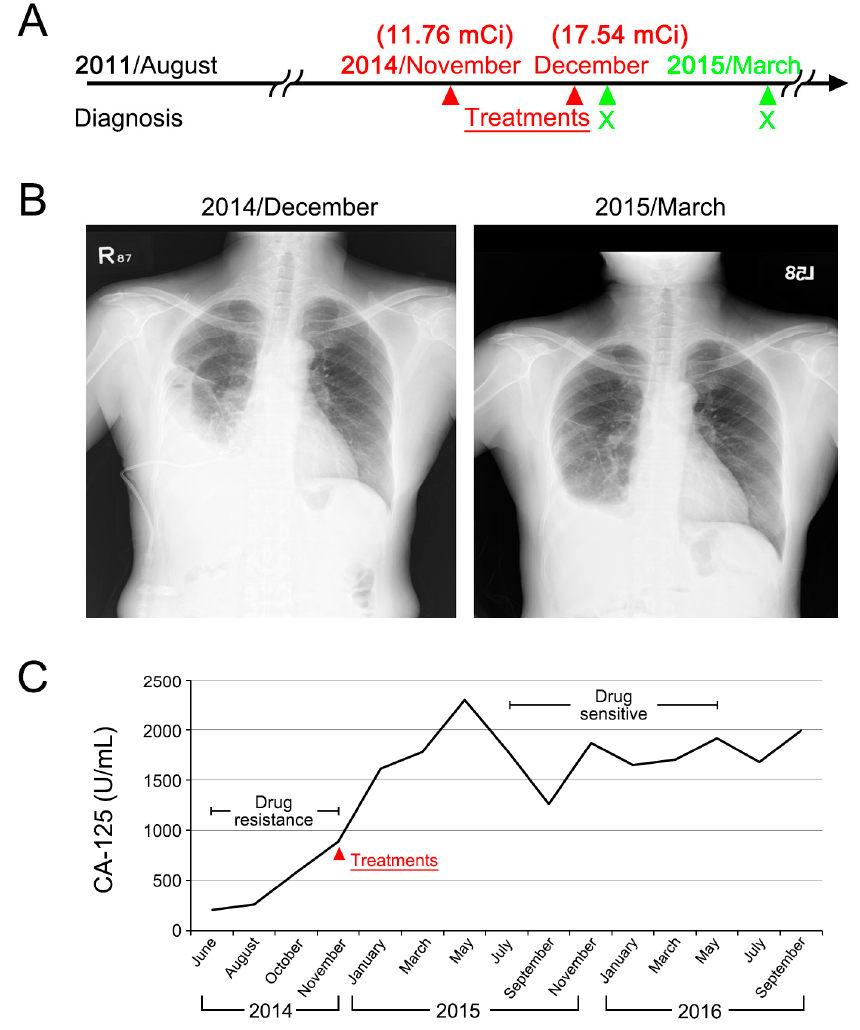
Figure 6. Case 1 presentation of a 188 Re-liposome phase I trial. ( A ) Clinical treatment scheme; ( B ) chest film before and after 188 Re-liposome treatment; ( C ) monitoring of serum CA-125.